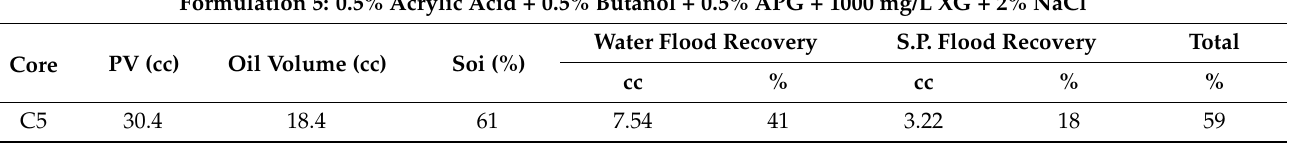
Table 9. Flood results for acrylic acid, butanol, APG 264, and Xanthan gum blend.